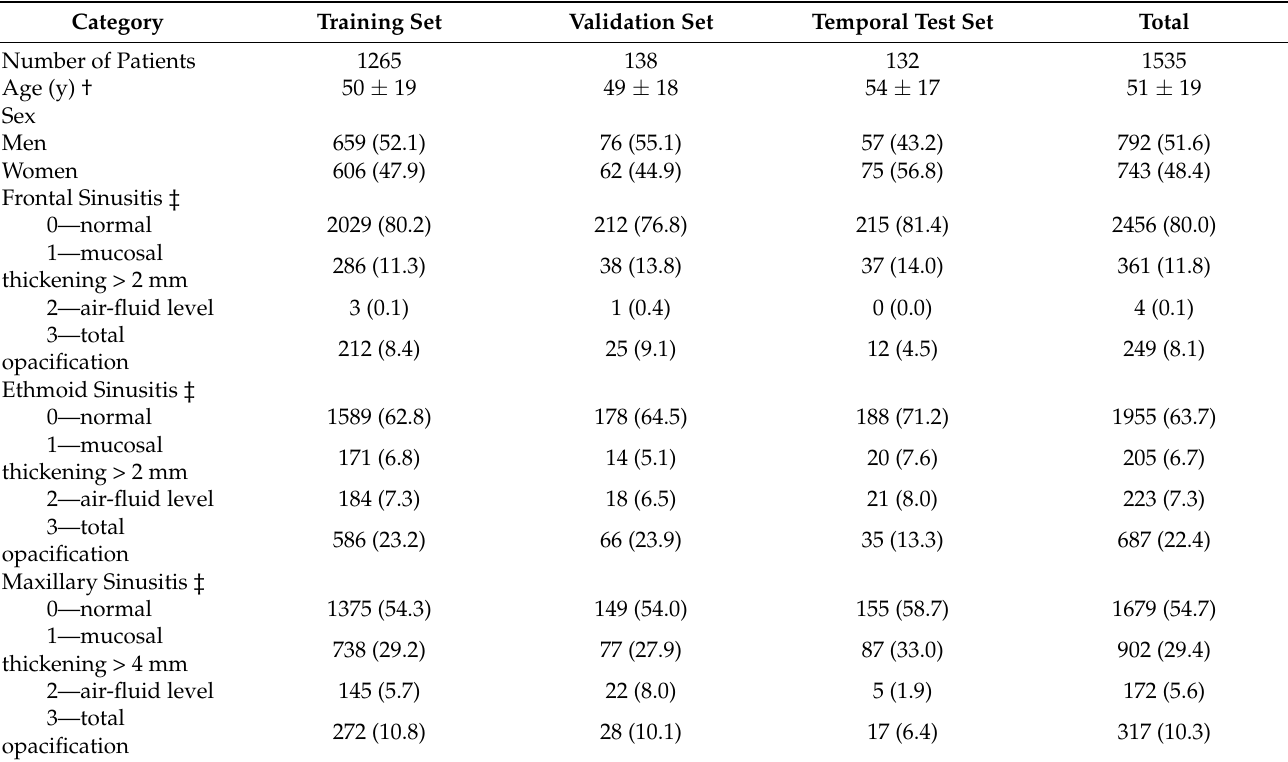
Table 1. Patient characteristics and label distribution of training, validation, and temporal test set.